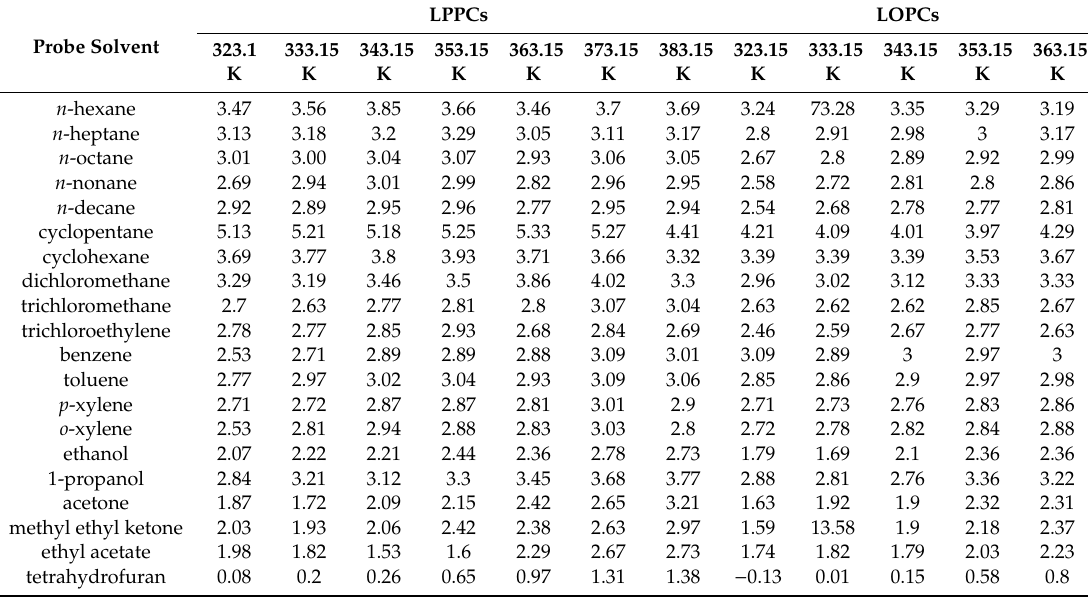
Table A4. Flory–Huggins interaction parameters χ ∞ di ff erent temperatures.